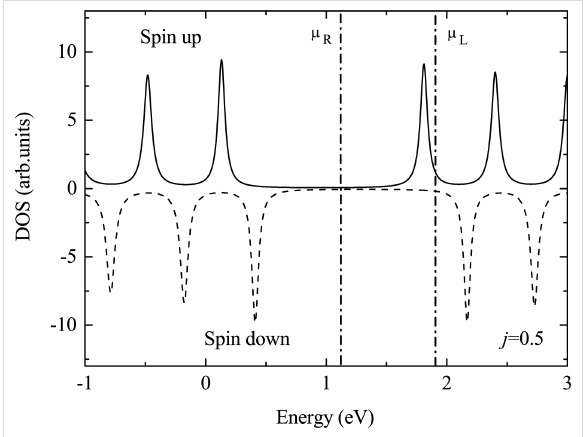
Figure 3: Density of states of the OF device at a bias of 0.8 V. Here, the Fermi energy of the electrodes is taken to be E F = 1.5 eV, which for a bias voltage of V = 0.8 V leads to the indicated chemical poten- tials μ L,R = E F ± 0.4 eV. Reproduced with permission from [31], copy- right 2007 American Physical Society.